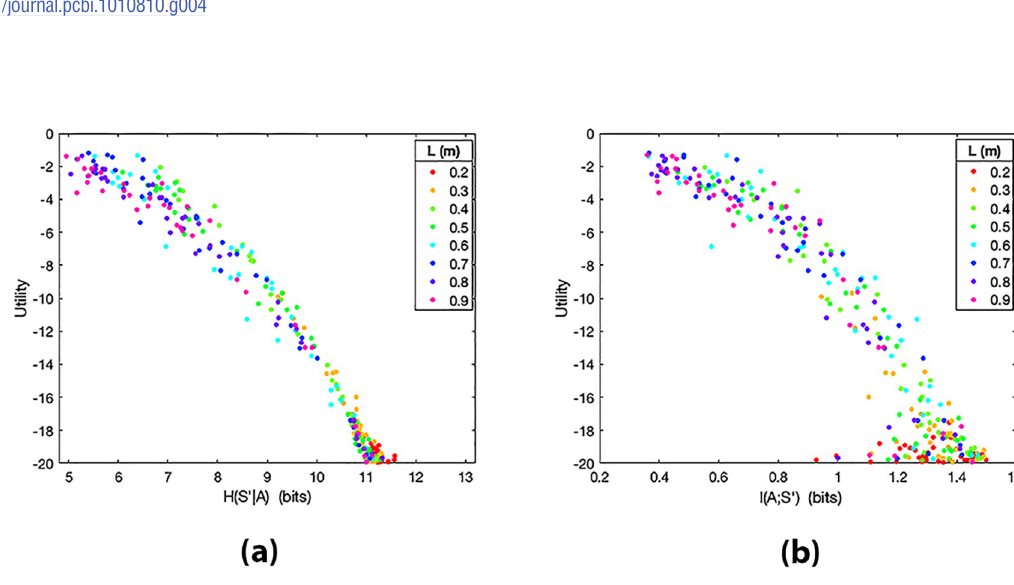
PLOS Computational Biology | https://doi.org/10.1371/journal.pcbi.1010810 January6, 2023 10 /